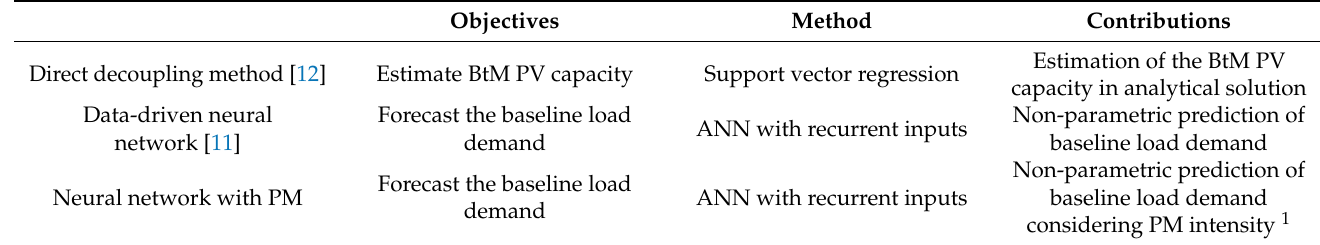
Table 1. Comparison of load demand forecast methods with BtM PV